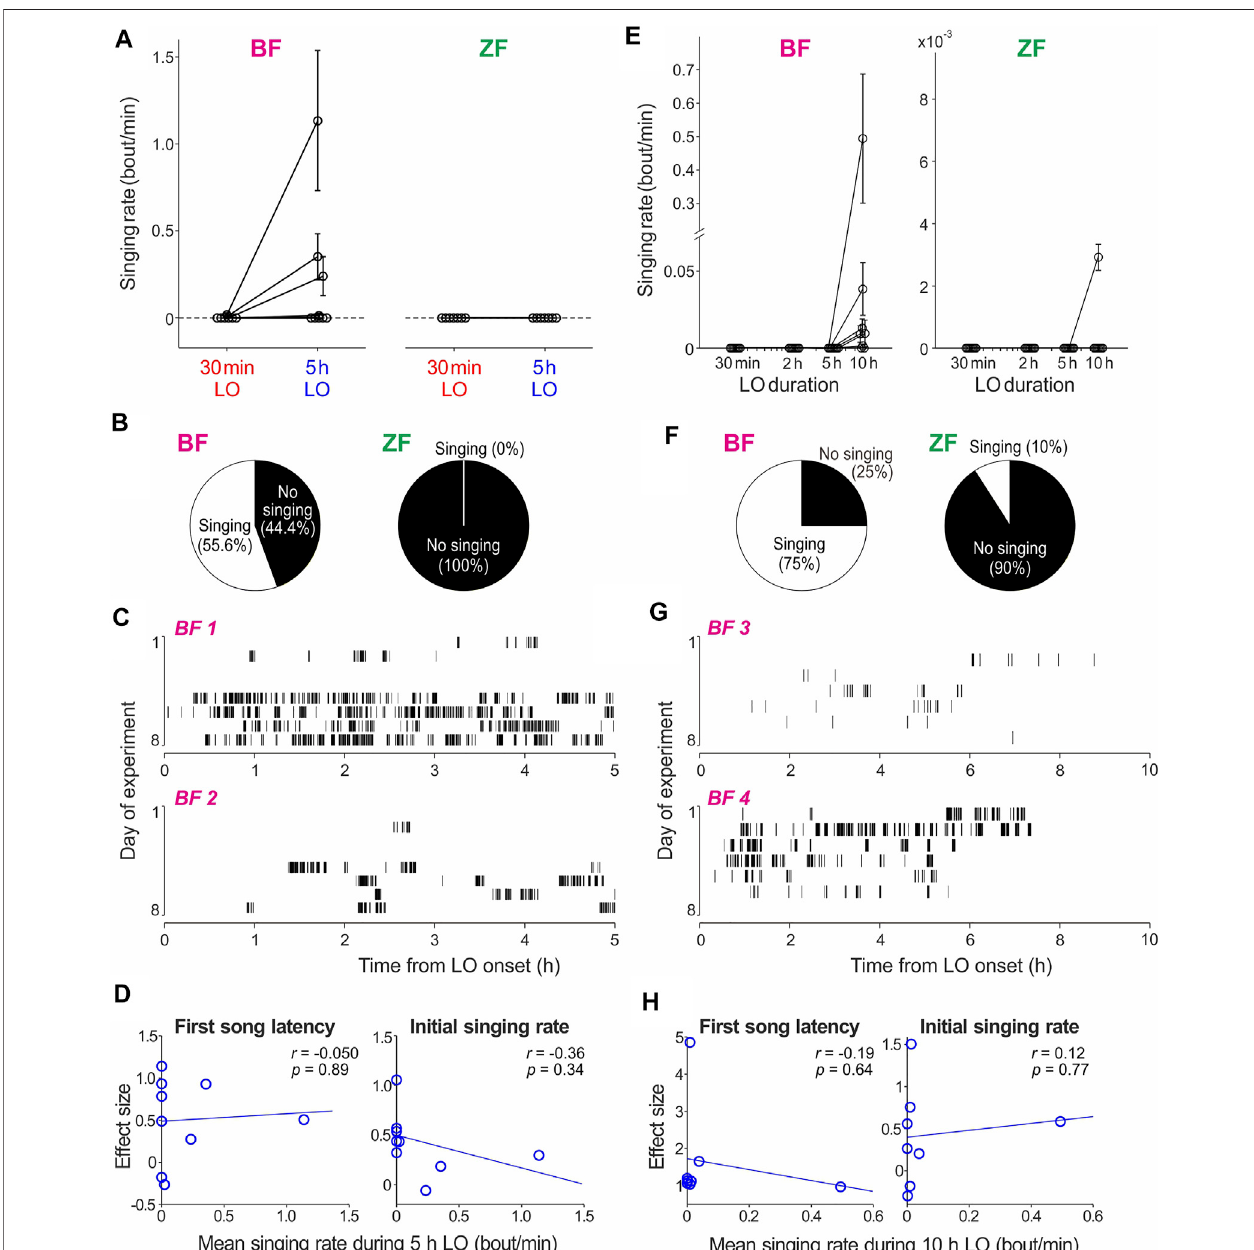
FIGURE3| Comparison ofBFandZFsingingbehaviorduringLOperiods. (A) Meansingingratesduring30 minand5 hLOperiodsinBFsandZFs( n =9BFsand 7 ZFs). (B) Percentage ofBFs and ZFsthat sung during 5 h LOperiods. (C) Raster plots ofsongbouts produced during a5 hLO in2 representative BFs. (D) Forall BFs examined, the effect sizes of fi rst song latency (left) and initial singing rate (right) between the 30 min and 5 h LO are plotted against mean singing rate during 5 h LO periods. (E) Mean singing rates during LO periods with four different durations in BFs and ZFs ( n = 8 BFs and 10 ZFs). (F) Percentage of BFs and ZFs that sung during 10 h LO periods. (G) Raster plots of song bouts produced during a 10 h LO period in two representative BFs. (H) Effect sizes of fi rst song latency (left) and initial singing rate (right) between a 30 min and 10 h LO, plotted against mean singing rate during a 10 h LO.